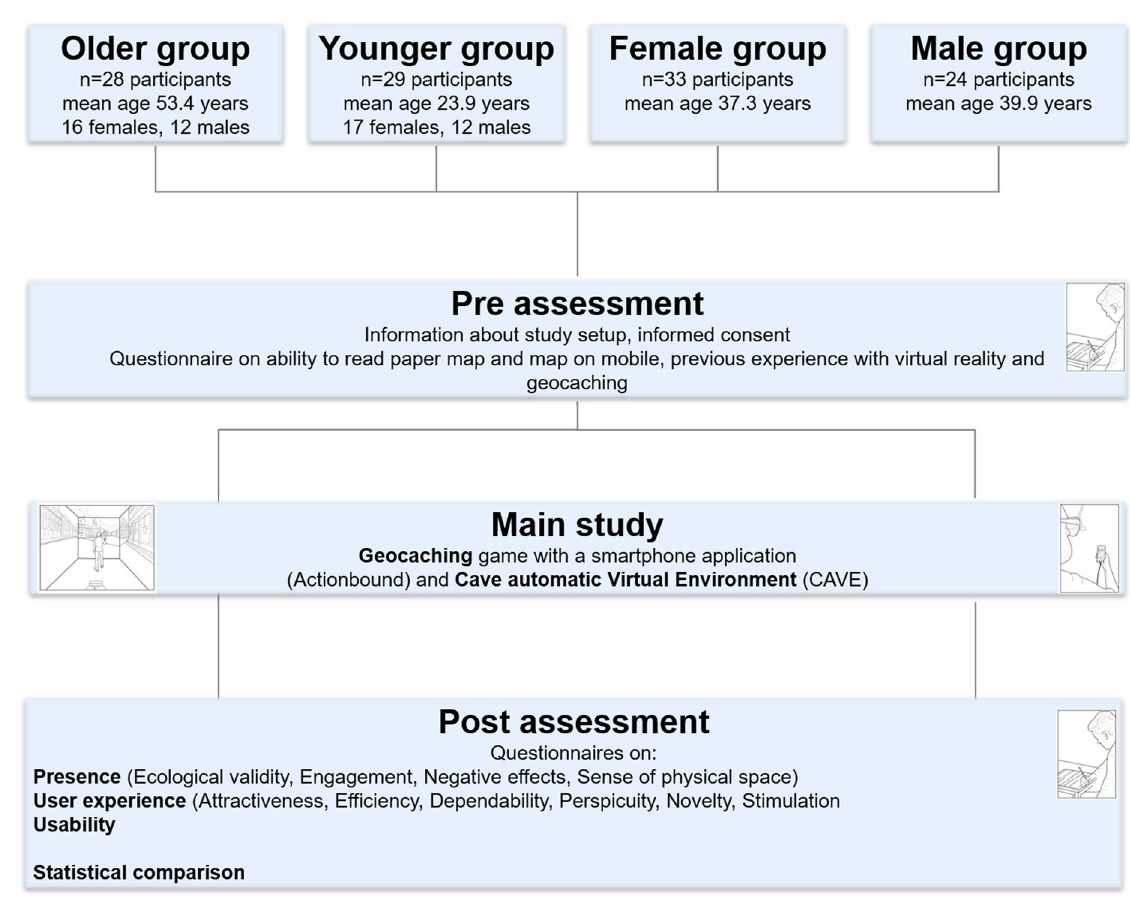
Fig 1. Graphical representation of the experimental procedure (Drawings by Robbie